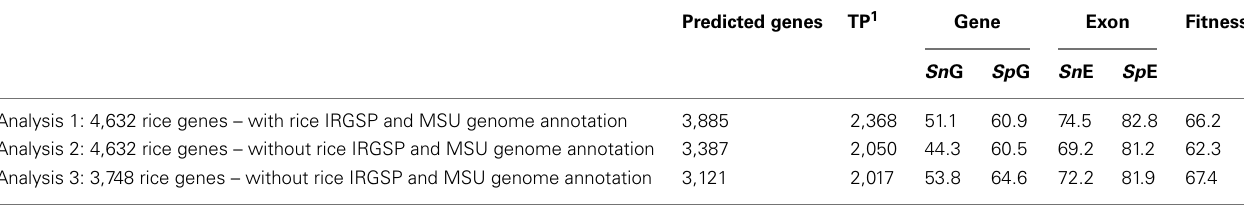
Table 2 | Evaluation of theTriAnnot fitness for the annotation of rice chromosome 1 using the IRGSP/RAP build5